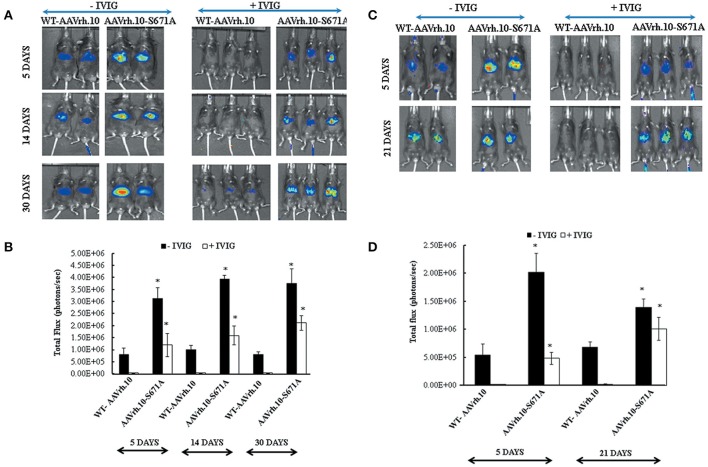
AAVrh.10-S671A mutant vectors resist neutralization by circulating antibodies in vivo. IVIG from Intratect®, Biotest, Dreieich, Germany (2mg/animal) was injected intra-peritoneally into C57BL/6 mice 24 h prior to administration of the WT-AAVrh.10 and the AAVrh.10-S671A vectors. C57BL/6 mice that were not administered with IVIG were also injected with these vectors (control group). Panel (A) Bio-luminescence imaging of mice administered with WT-AAVrh.10 or its mutant in the presence or absence of IVIG at 5, 14, and 30 days post-vector transduction. Panel (C) represents the experiment performed under the same conditions but with a different IVIG source (IVIGlob® EX, VHB Life Sciences Ltd, Mumbai, India). Panel (B,D) represent quantified data of the luciferase expression obtained from (A,C), respectively. *p < 0.05, in comparison to control group. Representative images are shown in the figure.